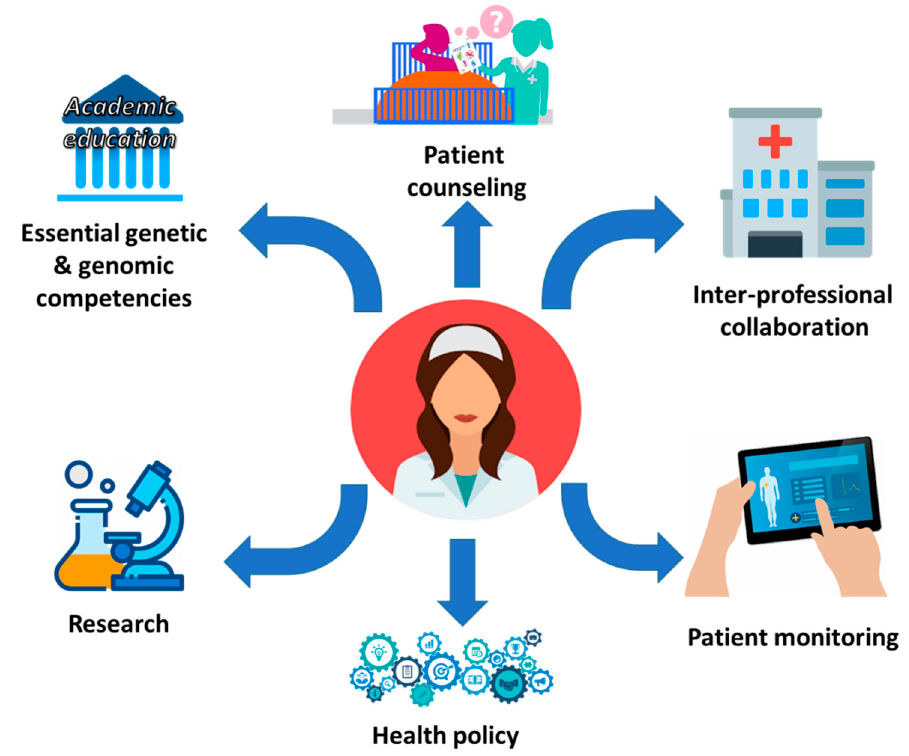
Figure 4. NP’s competencies regarding PM knowledge will give them an updated role in a modern healthcare system.